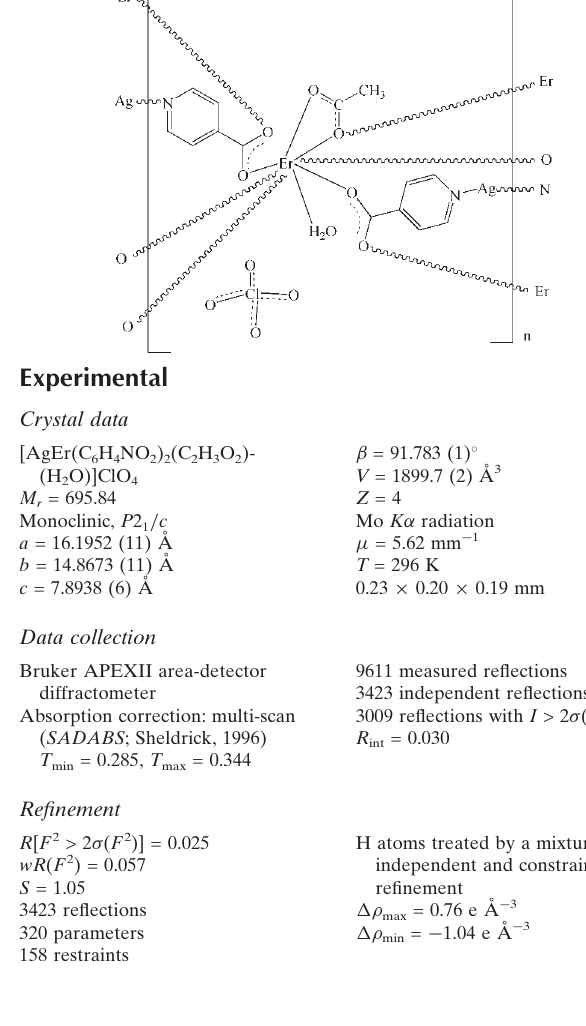
Hydrogen-bond geometry (A˚ , (cid:3) ). D —H (cid:2)(cid:2)(cid:2)